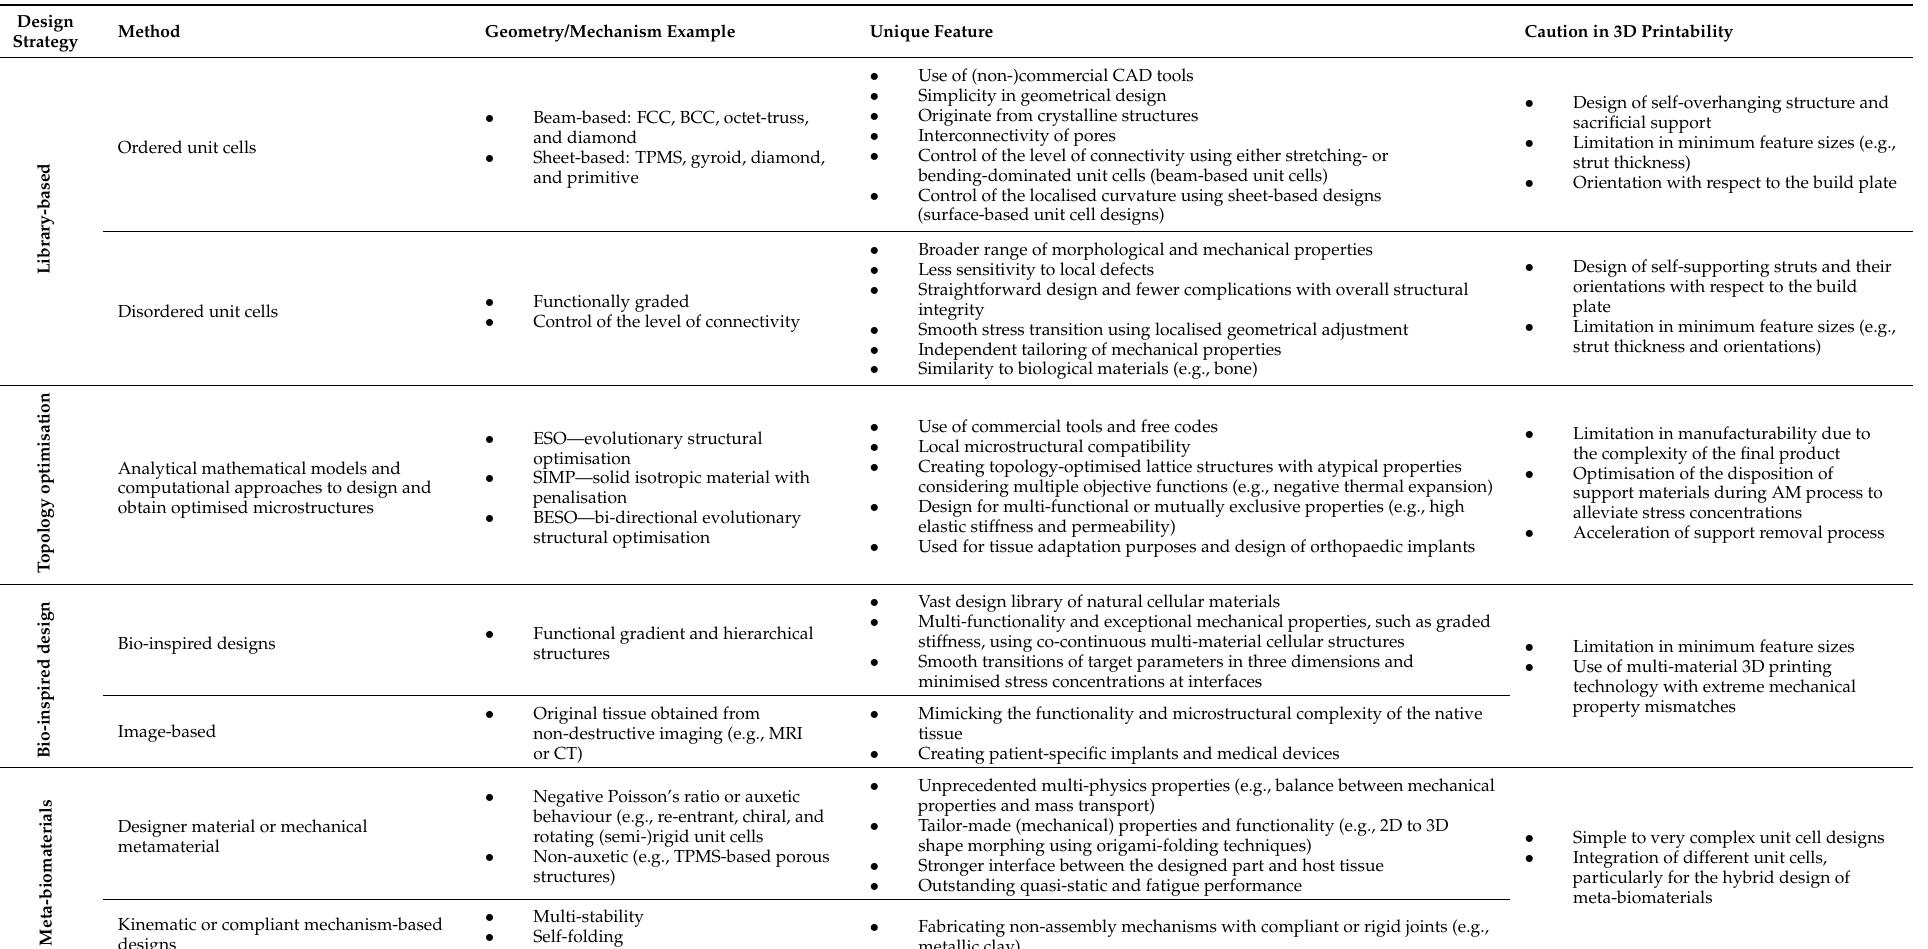
Table 2. Summary of the different approaches for the geometrical design of